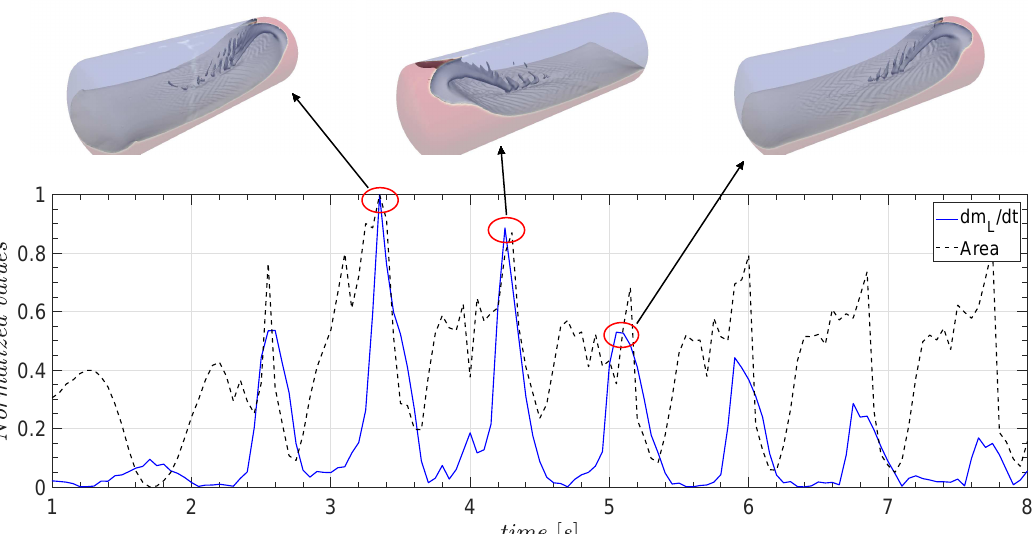
Figure 10. Correspondence of the interface area and condensation mass flux estimated from the measured pressure in case